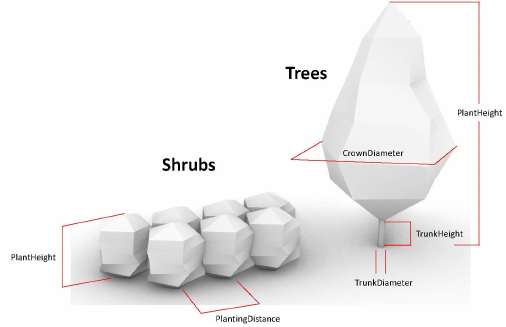
Figure 2. PlantHeight, PlantingDistance, TrunkDiameter, TrunkHeight parameters affect the size or distribution.